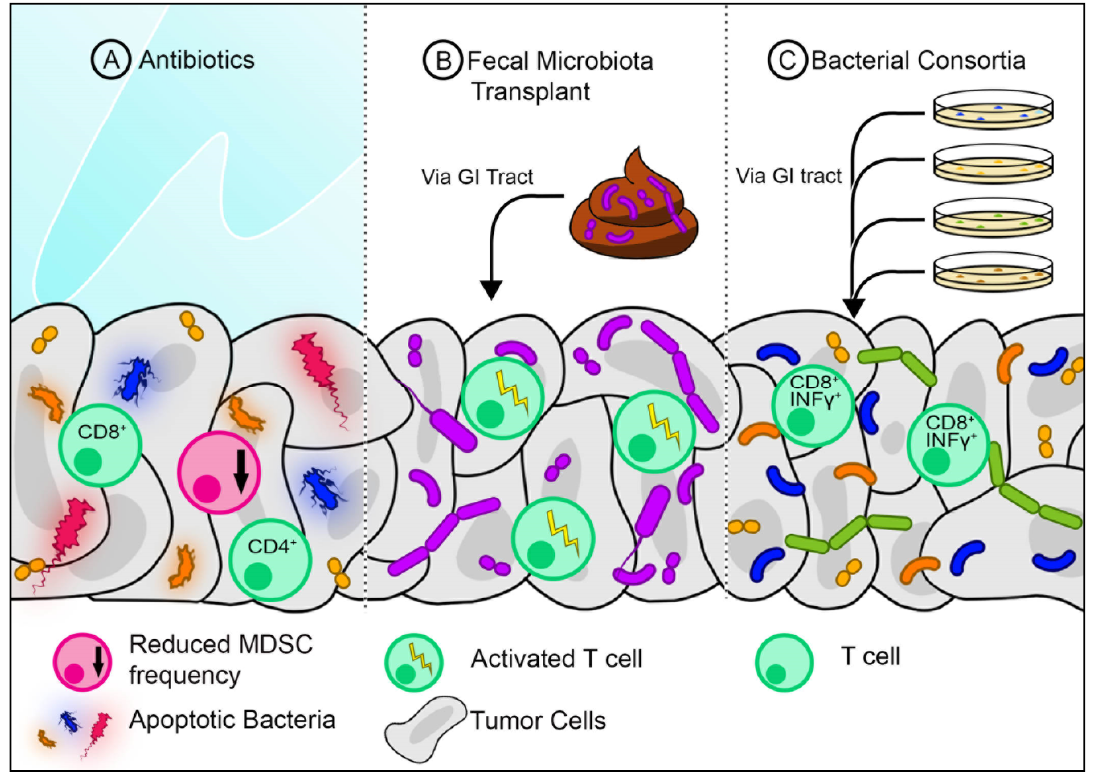
Figure 2. Strategies for modifying the tumor microbiome. ( A ) Antibiotics eliminate certain bacteria and may reduce frequencies of myeloid-derived suppressor cells (MDSC) while also increasing the frequency of CD4 + and CD8 + T-cells. ( B ) Fecal microbiota transplants from healthy individuals can introduce new bacteria into the gut, where in addition to re-establishing gut microbiome diversity, some of the newly introduced bacteria may translocate to the tumor. These bacteria may activate certain T-cell populations. ( C ) A Consortium of bacteria of known species grown in vitro can be introduced to the gut where it can translocate to the tumor. Certain combinations of bacterial species can activate anti-tumor CD8 + T-cells.